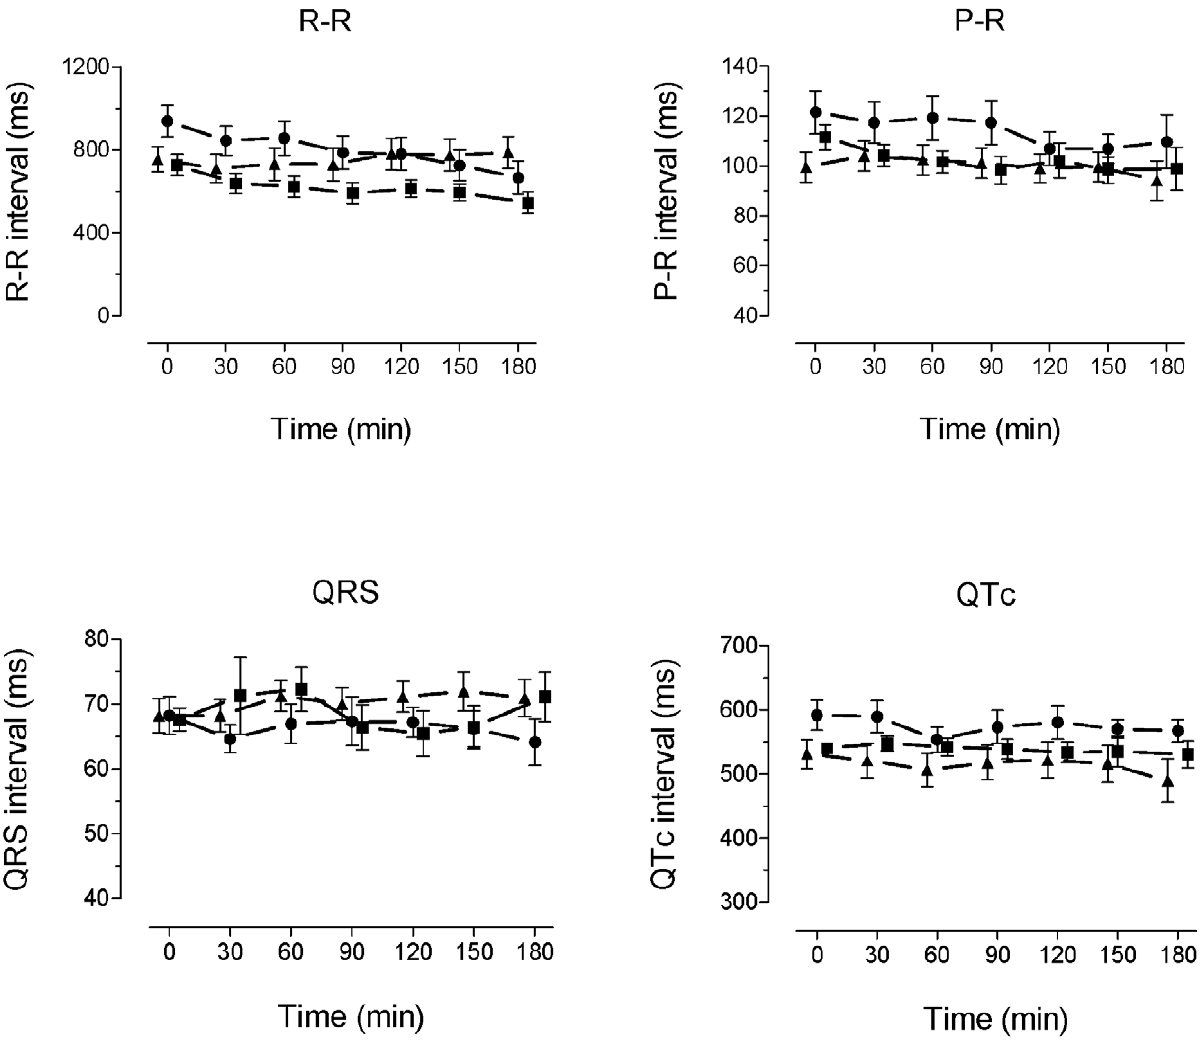
Figure 4. Time course of ECG intervals. Plots of R-R, P-R, QRS and QTc intervals during the experiment. Data are shown for 30, 60, 90, 120, 150 and 180 min after ligation (points are displaced for clarity). Symbols show mean + / 2 SEM. Control = filled circles, riluzole = filled squares, lidocaine = filled triangles.